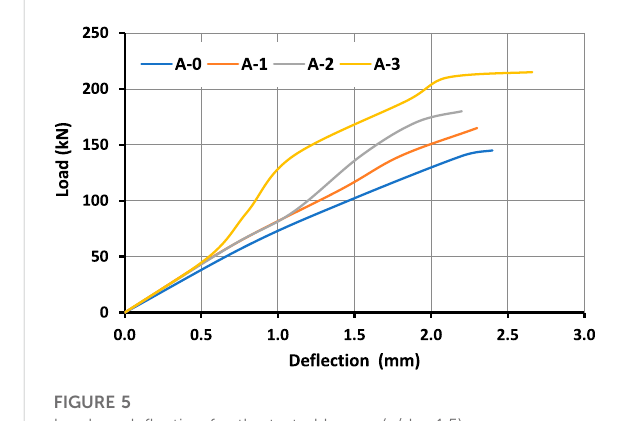
FIGURE 3 Reinforcement details.